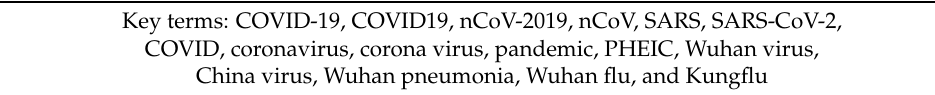
Table 1. Key terms for COVID-19-related tweet extraction.